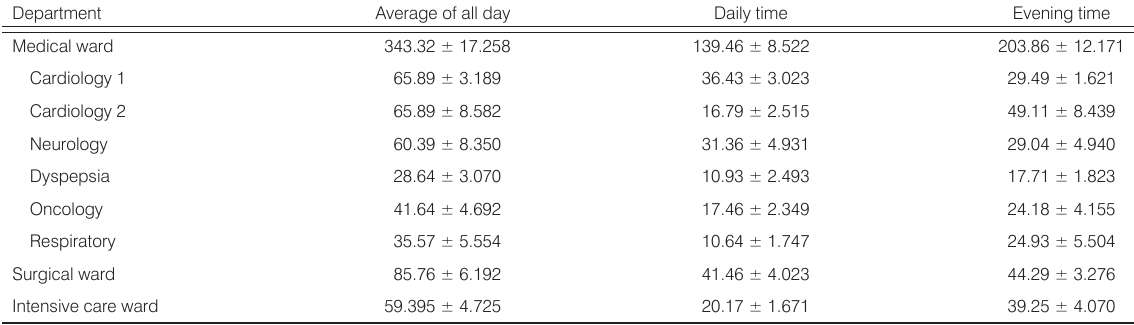
Table 1. The average number of naked medicine in all day and other each time zone (M ± SD)